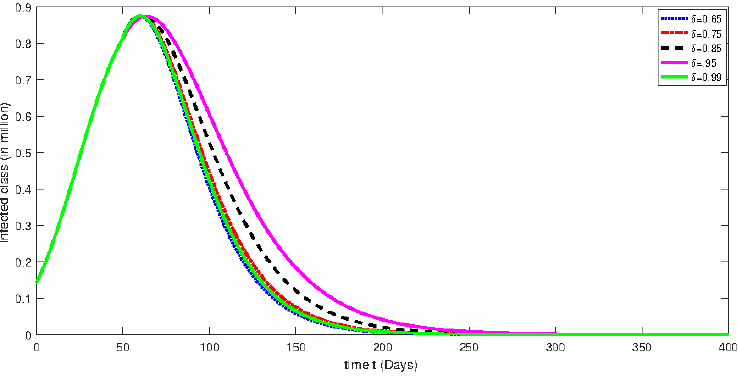
Figure 8. Numerical solution for infected class for the given days and using different fractional orders with isolation rate of 50%.